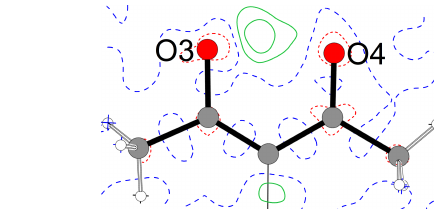
− 3 (red: positive difference, green: